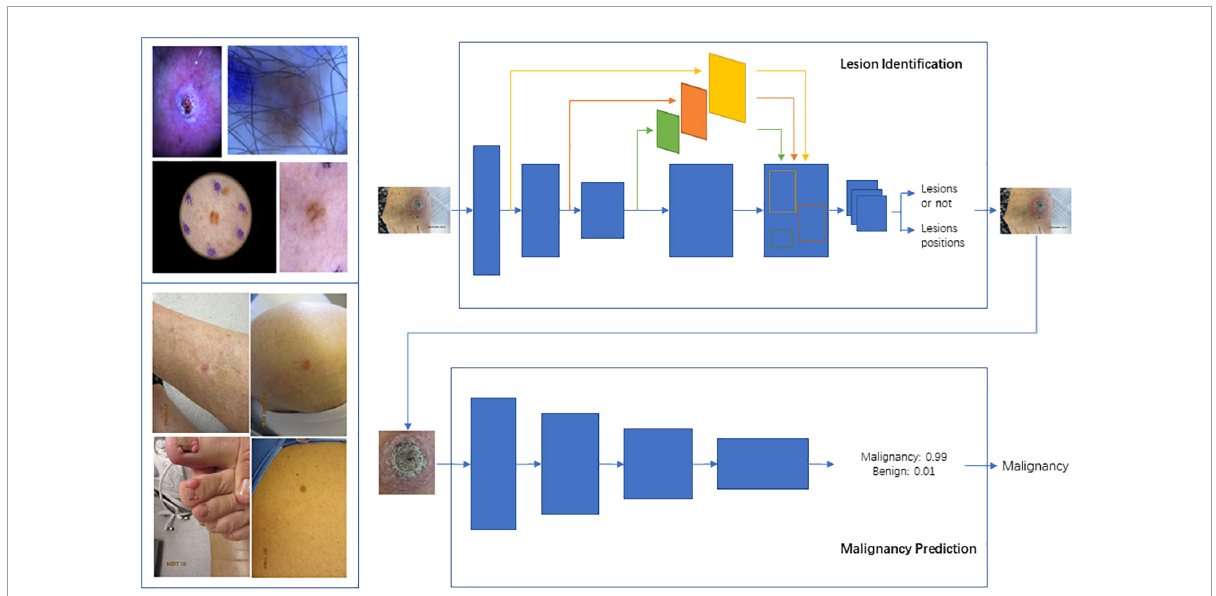
FIGURE2 Schema for Lesion Identification and malignancy detection. Two-stage malignancy prediction and lesion identification Framework. (Top left) Examples of dermoscopy images. (Bottom left) Examples of wide-field images. (Top right) The lesion identification model estimates lesion locations (bounding boxes) from whole images (dermoscopy or wide-field) via a faster-RCNN architecture. (Bottom right) The malignancy prediction model specified via a ResNet-50 architecture predicts the likelihood that a lesion is malignant. The lesions identified by the lesion identification model are fed into the malignancy prediction model for end-to-end